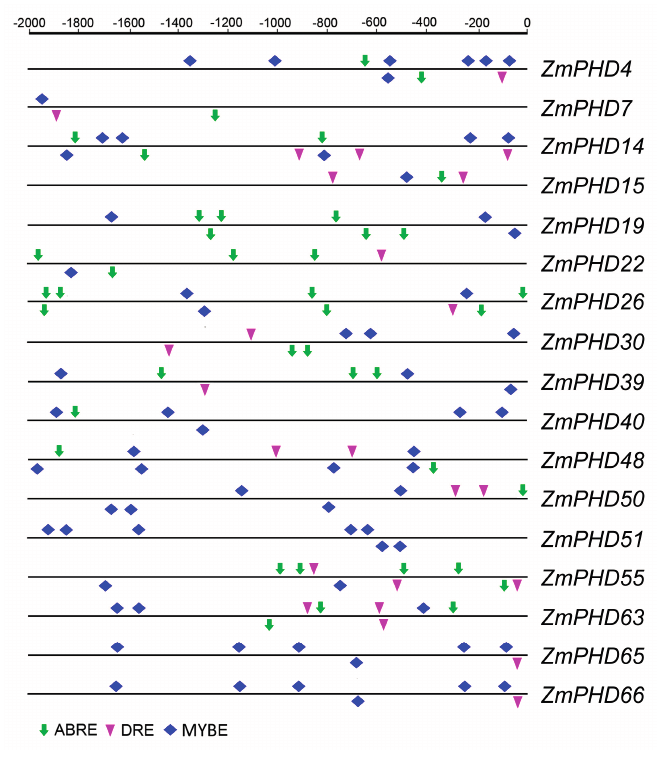
Figure 6. Cis -elements in the promoter regions of maize putative stress-responsive PHD genes. The stress-responsive cis -elements distributed on the sense strand and reverse strand are shown above and below the grey lines, respectively. ABRE, MYB and DRE core sequences are indicated by green thick drop-down arrows, pink triangles and blue squares, respectively. ABRE: ABA responsive element; MYB: MYB-binding site cis -element; DRE: dehydration-responsive